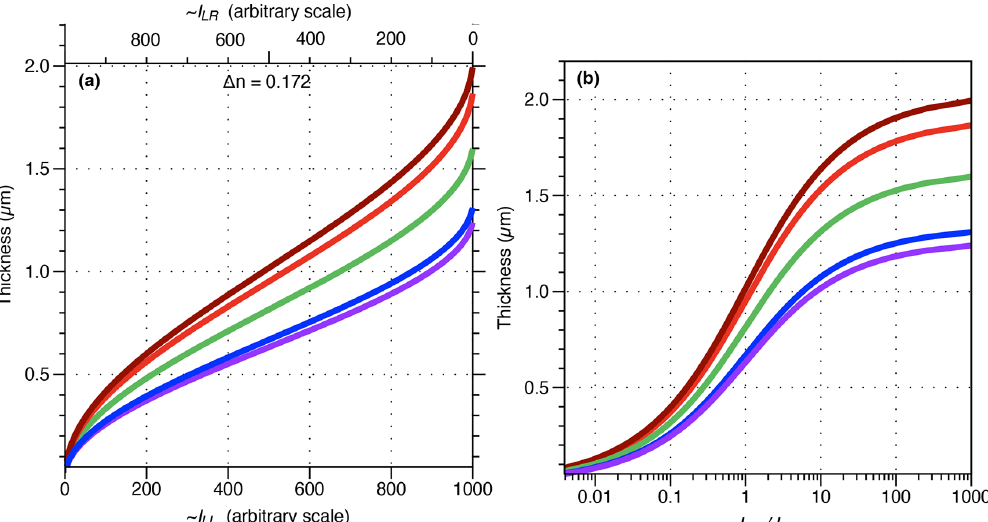
Figure 1. (a) Light intensity (arbitrary scale from min = 0 to max = 1000) going through a left circular polarizer ( I LL ) (top scale) or a right circular polarizer ( I LR ) (bottom scale) associated with a left circular analyser in relation to the thickness of calcite crystals (birefringence (cid:49)n = 0.172), under monochromatic light of wavelengths of 435nm (indigo curve), 460nm (blue curve), 561nm (green curve), 665nm (red curve) and 700nm (brown curve). (b) Light intensity ratio ( I LR /I LL ) under monochromatic light of the same wavelength as in (a) in relation to calcite crystal thickness. Table 1. Microscope parameters and inferred precision of the optics and measurements. Wavelength ( λ ) Numerical Numerical Optical Maximum Theoretical Practical Equivalent aperture aperture resolution measurable thickness thickness mass of lens condenser thickness resolution (8bit) reproducibility resolution Equation/symbol LNa CNa λ /(2 × LNa) λ /(2 × 172) λ /(2 × 172 × 256) RMCE RMCE (µm) ×